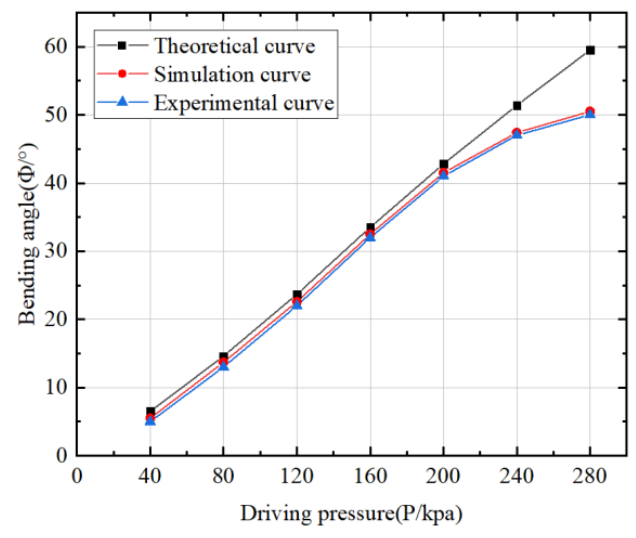
Figure 13. Actuator bending deformation error analysis diagram.